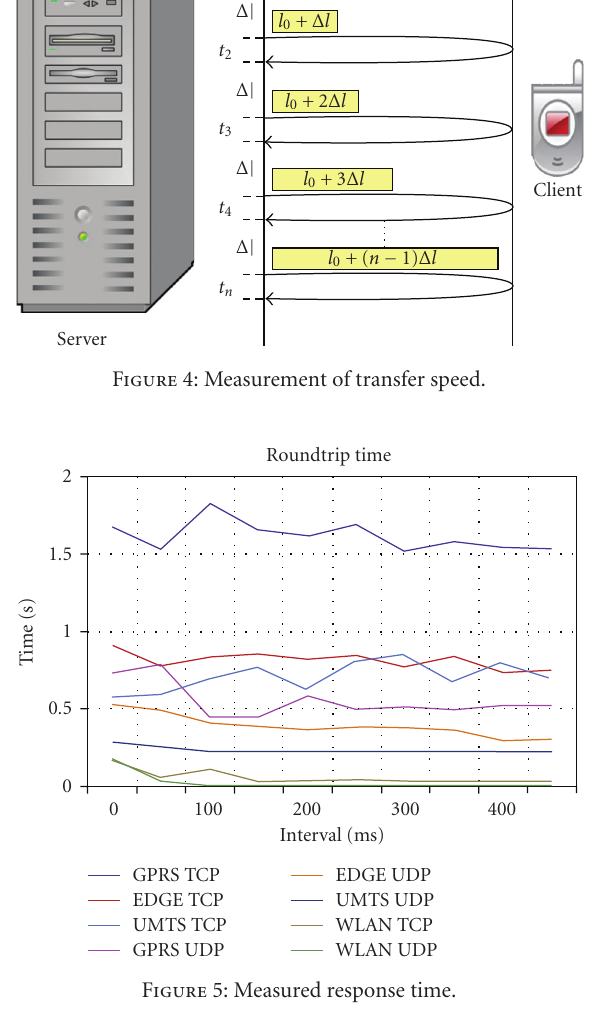
Figure 5: Measured response time.